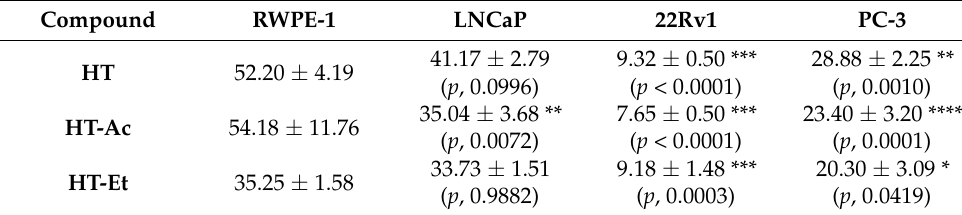
Table 1. Half inhibitory concentrations (IC 50 ) of proliferation rates of RWPE-1, LNCaP, 22Rv1, and PC-3 cell lines after 48 h of treatment with HT and selected derivatives. Data are expressed as the mean of IC 50 ( µ M) ± SEM (4 experiments). Compound RWPE-1 LNCaP 22Rv1 PC-3 HT 52.20 ± 4.19 HT-Ac 54.18 ± 11.76